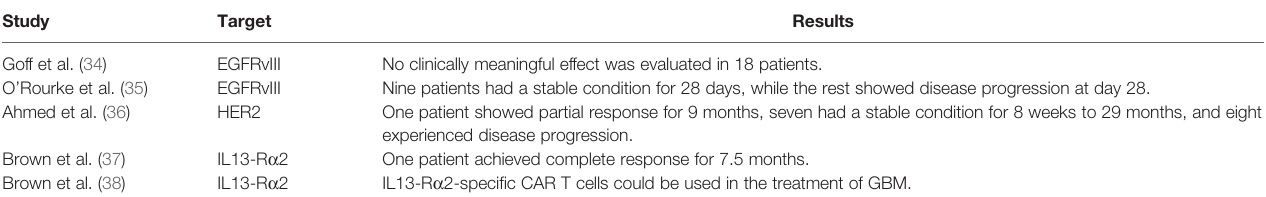
TABLE 1 | Published clinical trials of CAR T therapy in GBM.